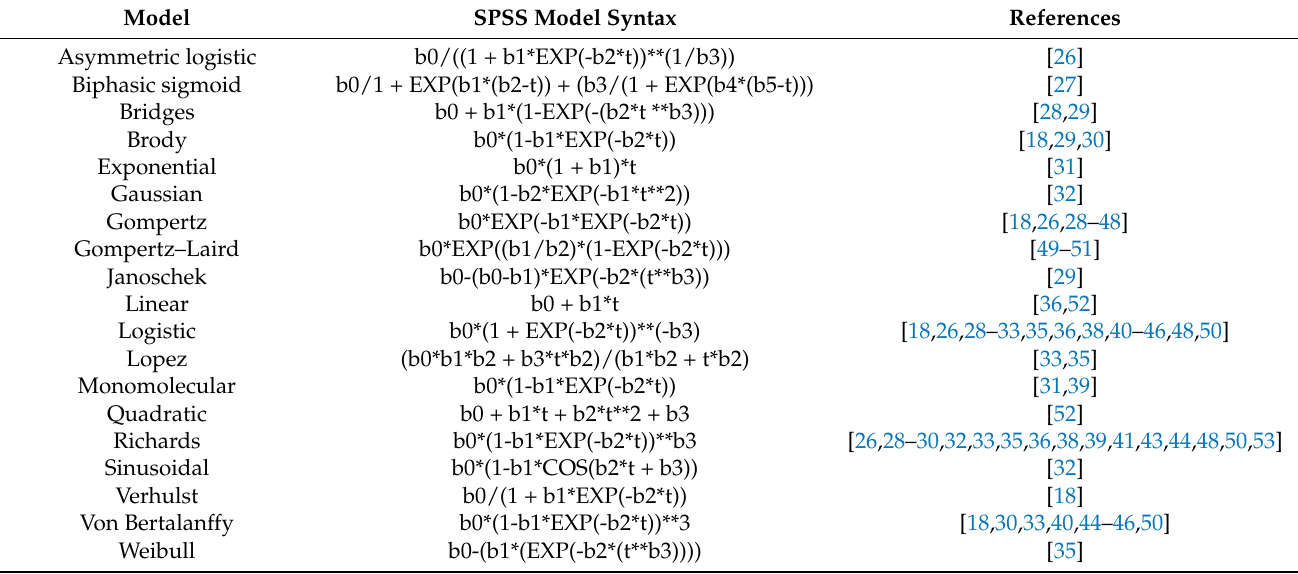
Table 3. SPSS Model syntax of mathematical